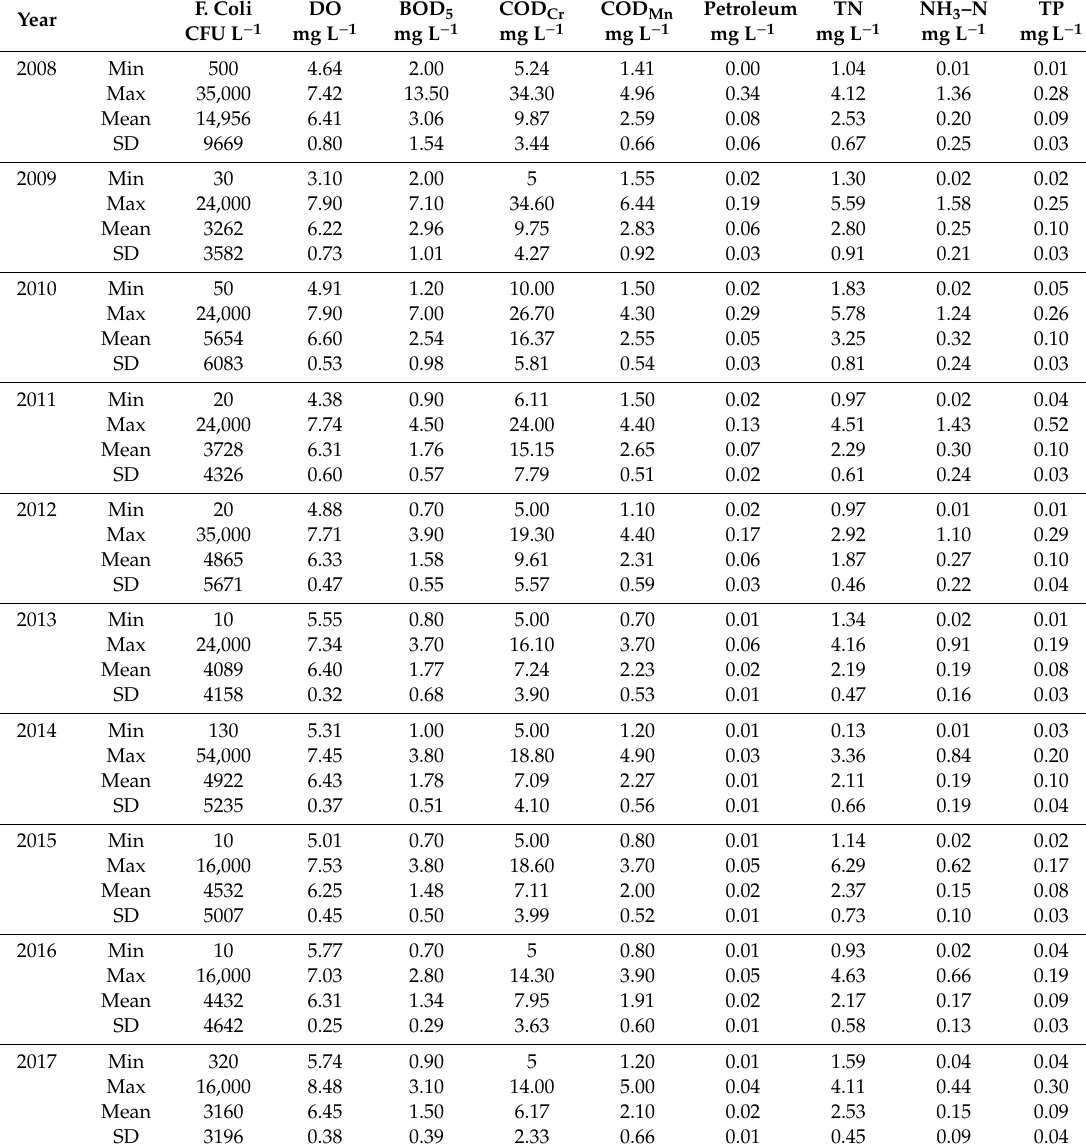
Table 2. Summary of statistical analyses for microbiological parameters, physiochemical parameters, and nutrients in water from the Pearl River Estuary (South Guangzhou).